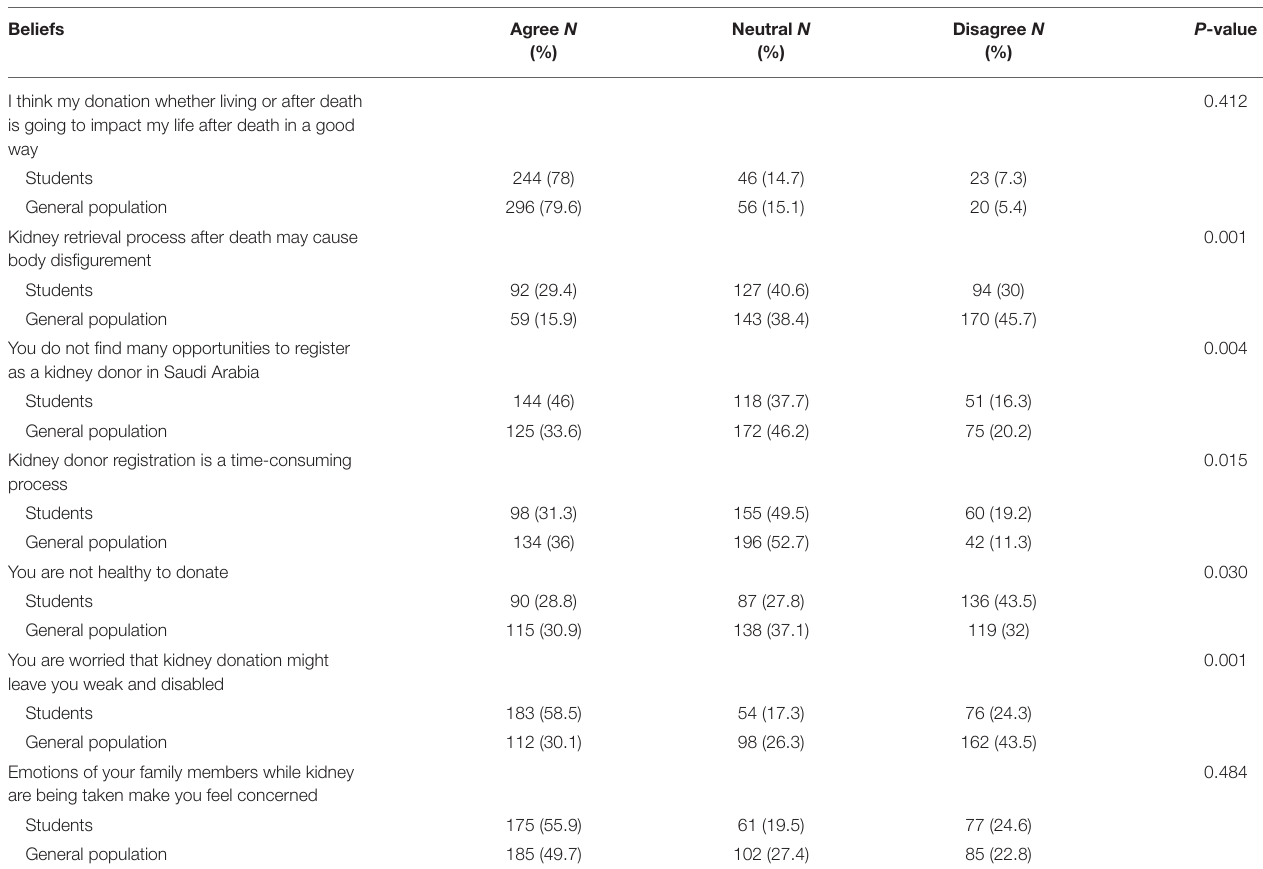
TABLE 8 | Correlation between beliefs and willingness. Beliefs Agree N